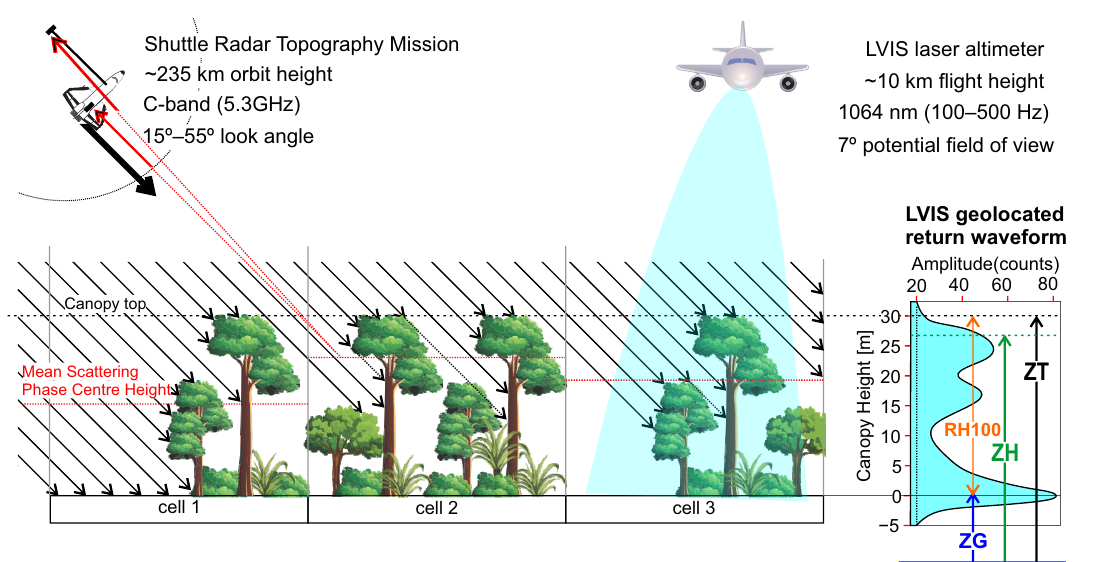
Figure 8. Schematic 2D representation of Shuttle Radar Topography Mission (SRTM) and LVIS measurements for a cross-section of three cells with ≈ 50%, 100%, and 67% vegetation cover, as viewed from above. The SRTM C-band signal is emitted from the main antenna at a 5.3GHz frequency and a varying look angle. Indicative “sight” black lines reach the surface at a 45° angle; arrows indicate the points of contact with the ground/vegetation. The part of the signal returned to the Shuttle (red arrows) is collected by two antennas, the second placed on a 60m-long mast. The signal phase difference allowed the determination of the mean scattering phase centre heights. On the right, the vertical axis indicates canopy heights above the ground; the axis is shared with the LVIS return waveform schematic. The LVIS laser altimeter measurement principle is based on the emission of 1064nm wavelength pulses at up to a 500Hz repetition rate [29]. The figure shows the cone of an ≈ 25m diameter reaching the surface at its maximum 7° look angle. Knowing (1) the precise time each laser pulse was emitted, (2) the pulse return time from the target, and (3) the shape of the return waveform allows the calculation of various parameters, such as the mean elevation of the lowest detected mode ZG, the mean elevation of the highest detected mode ZH, and the elevation of the highest detected signal ZT within each waveform. ZG is represented by a distinguishable curve that returns the latest. RH parameters stand for Relative Heights to ZG at which a certain percentage of the waveform energy occurs, e.g., RH100 is equal to